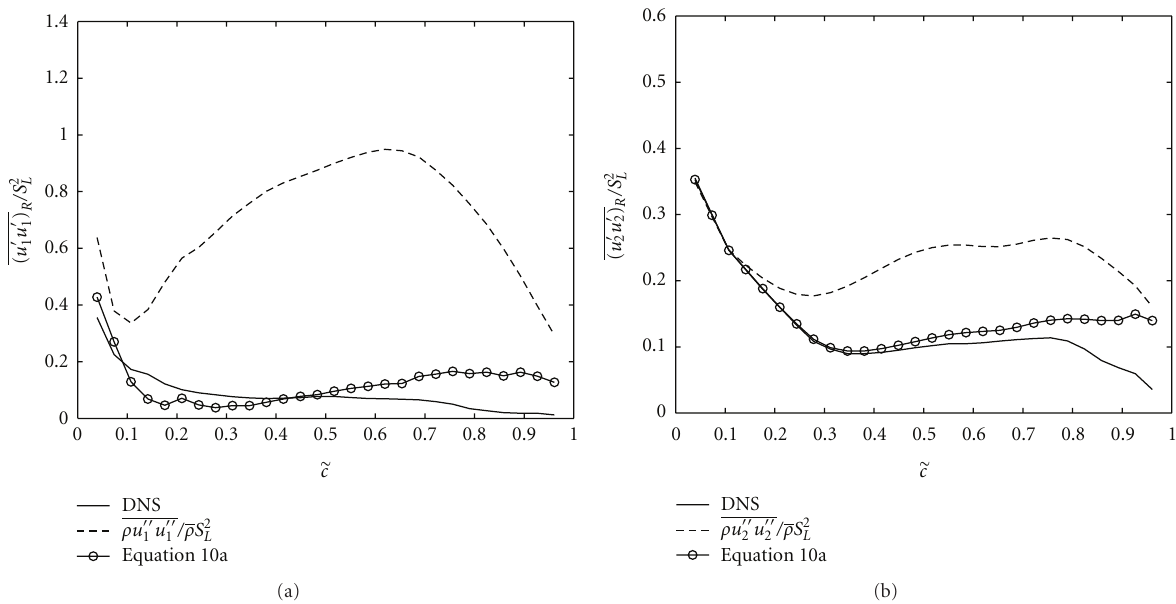
Figure 3: (a) Variations of ( u (cid:2) 1 u (cid:2) 1 ) and ρu (cid:2)(cid:2) 1 u (cid:2)(cid:2) 1 /ρS 2 with (cid:2) c across the flame brush along with the predictions of (10a). (b) Variations of /S 2 L L R ( u (cid:2) 2 u (cid:2) 2 ) and ρu (cid:2)(cid:2) 2 u (cid:2)(cid:2) 2 /ρS 2 with (cid:2) c across the flame brush along with the predictions of /S 2 L L R